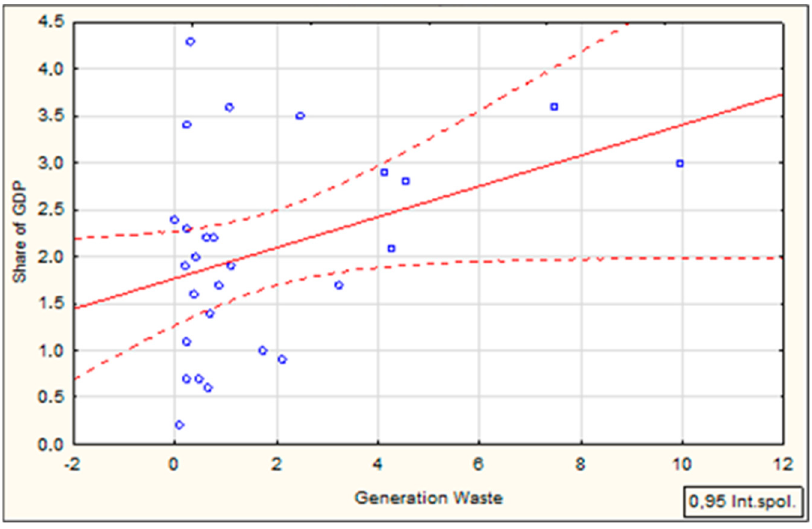
Figure 6. Correlation analysis.